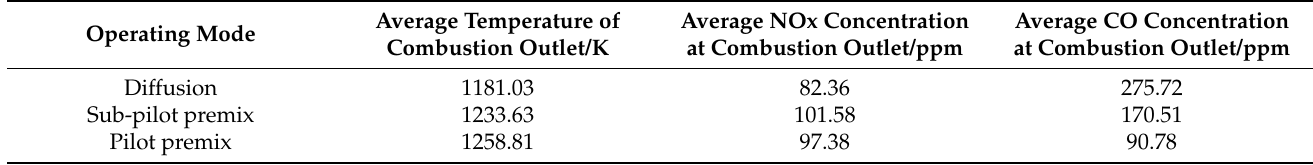
Table 6. Numerical simulation results of each operating mode under original conditions.